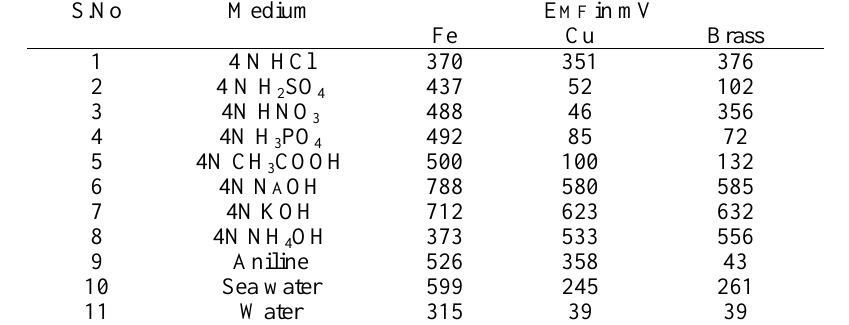
Table 2. Comparative corrosion study of metals and Alloy in different medium in terms of emf (mV)